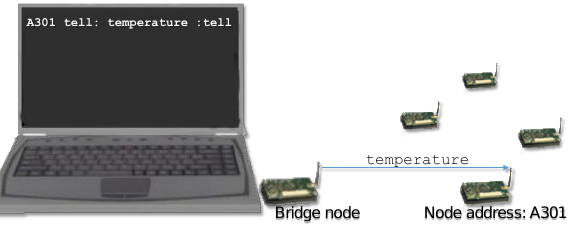
Figure 1. Executable code exchange to make a node sense the temperature quantity. To tell a node to locally perform temperature measurements, the user can interact with the bridge node interpreter by typing on its shell the sequence of words to exchange symbolic programs. The destination node address –the hexadecimal value A301 in the example– is expressed as a 16-bit value according to the IEEE802.15.4 short addressing mode. The word temperature is the symbolic program that is copied in the outgoing frame payload, sent as character string to be remotely